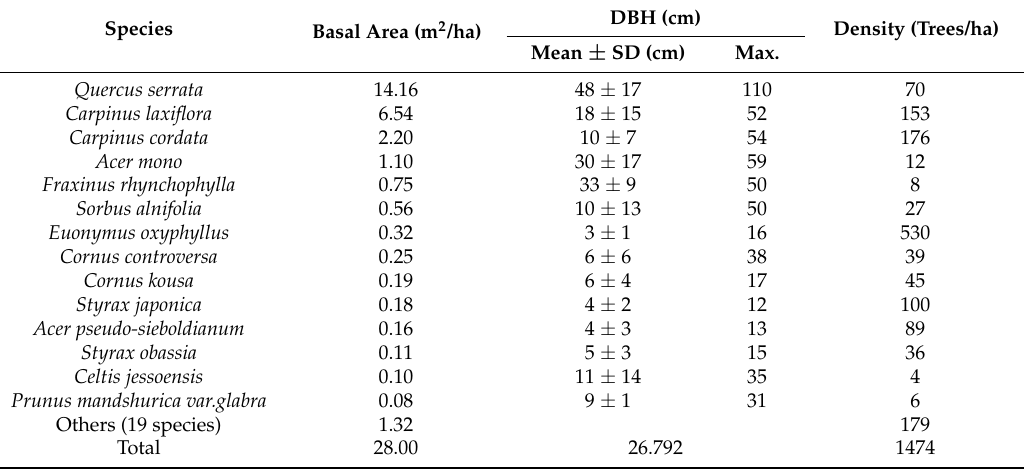
Table 5. The Kwangneung national forest permanent